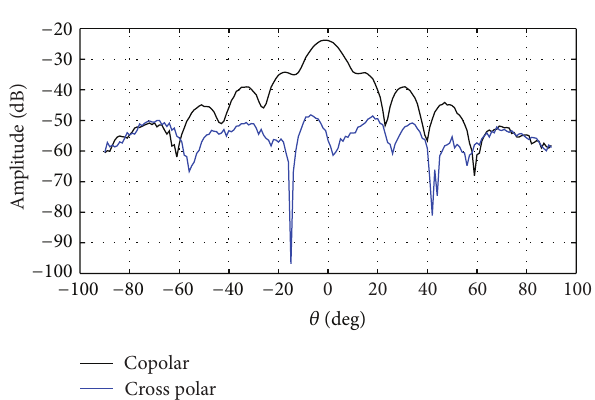
Figure 12: Measured radiation pattern of SAR-High antenna: copolar and cross polar components @ 900 MHz.